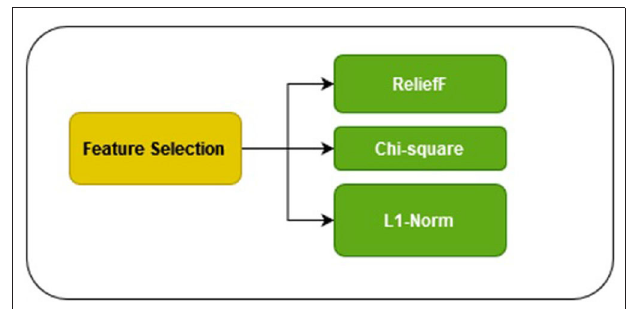
FIGURE 3 | Feature selection method used.